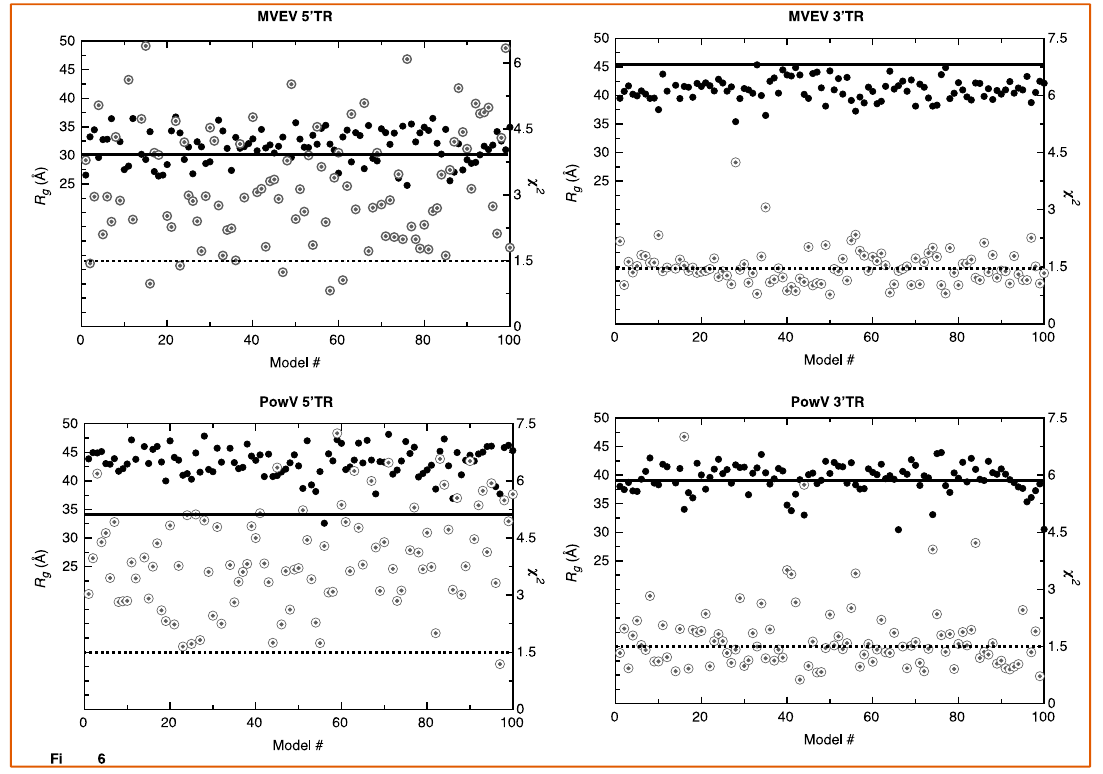
Figure 5. Screening of high-resolution structures calculated using MC-Sym [52] for MVEV 5’ TR, MVEV 3’TR, PowV 5’TR and PowV 3’TR. For each RNA, the x-axis represents model numbers (total 100 models), whereas the y1-axis (solid black circles) and y2-axis (grey double circles) represent R g (Å) and χ 2 values, respectively, calculated using CRYSOL package [53]. For each plot, the solid dark line corresponds to y1-axis and represents the value for experimentally determined R g (Å) as presented in Table 1. The dotted line corresponds to y2-axis and represents a χ 2 value of 1.5. These plots indicate that MC-Sym derived structures represent a wide-range of conformations these RNAs can theoretically adapt.